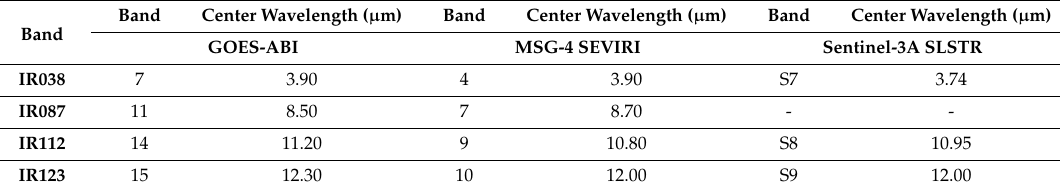
(Table 1), with other dependences on satellite zenith angle, first ‐ guess SST, coefficient set for latitude bands and month of year [2,28]. The IR038 band near the 3.7–3.9 μ m interval can be used to retrieve nighttime SST skin and correct dust aerosol effect [29–31]. Both ABI and SEVIRI are spectrally matched to three SLSTR bands, S7, S8, and S9, respectively. Additionally, ABI and SEVIRI have an IR086 band near 8.5–8.7 μ m for deriving SST skin . However, the SLSTR does not include a similar IR086 band in